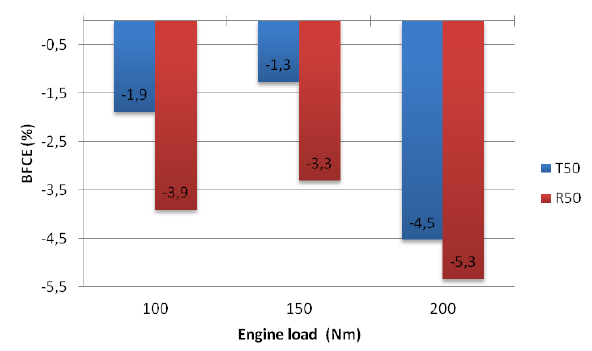
Fig. 2. Changes of BFCE in relation to DF for T50 and R50 under different engine load